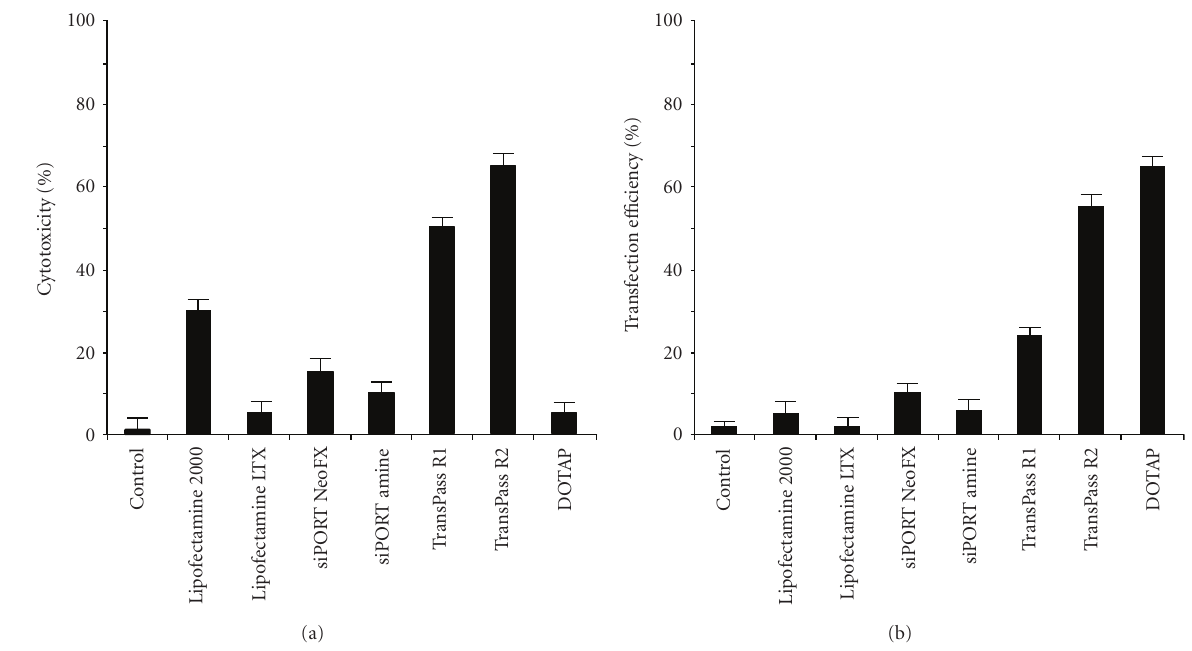
Figure 1: E ff ects of siRNA delivery agents on cytotoxicity and transfection rates . Freshly isolated HSCs were subjected to agent-specific transfection protocols using a fluorescein-labeled, nontargeting siRNA control as described in the Materials and Methods. After 24 hours incubation, cytotoxicity was assessed through the trypan blue dye exclusion test (a), while transfection rates were calculated from the ratio between fluorescein-labeled and total number of DAPI-stained cells (b). Data shown are representative of triplicate